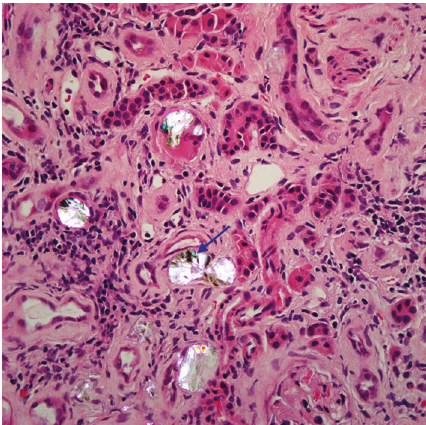
Figure 2: Hematoxylin and eosin stain of renal biopsy under polar- ized light (40x objective magnification) showing oxalate crystals with suggestion of “fan” like morphology (blue